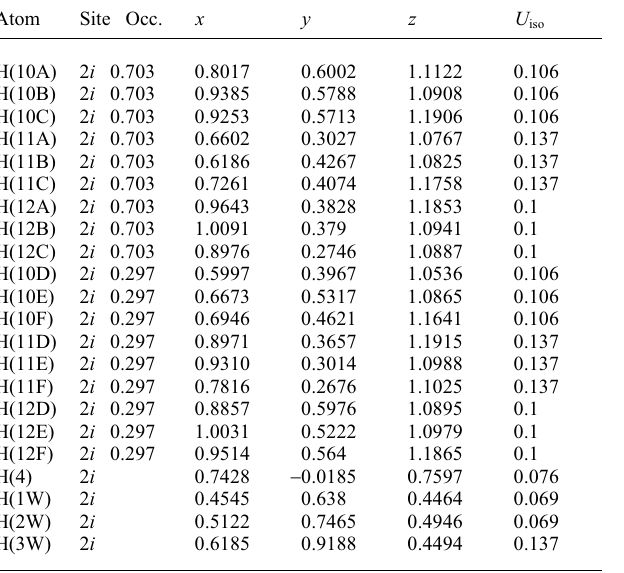
Table 2. Atomic coordinates and displacement parameters (in Å 2 ) . Atom Site